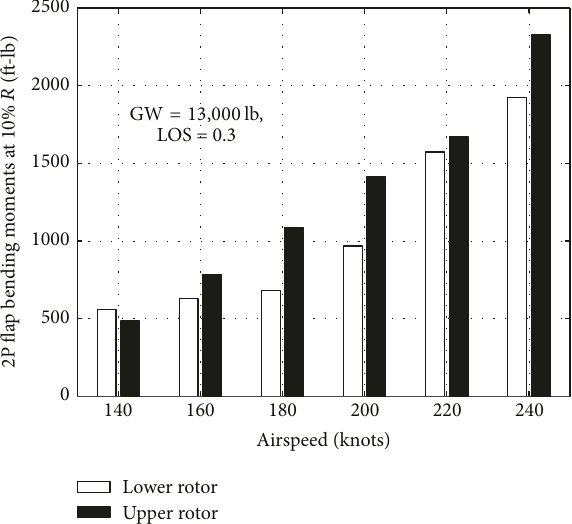
Figure 14: 2P flap bending moments at 10% R in compound helicopter